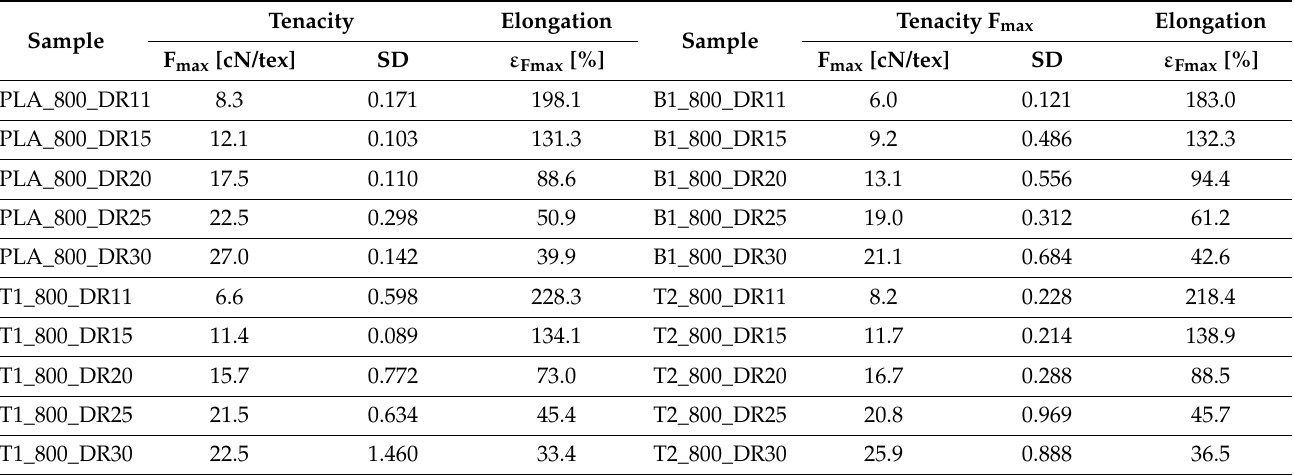
Figure 4. Tensilegram for as-spun fibers at 800 m/min take-up velocity and various draw ratios. The complete measurement curves are shown for samples containing 1% BHET (B1_800). Table 1. Data values for the samples displayed in Figure 4.